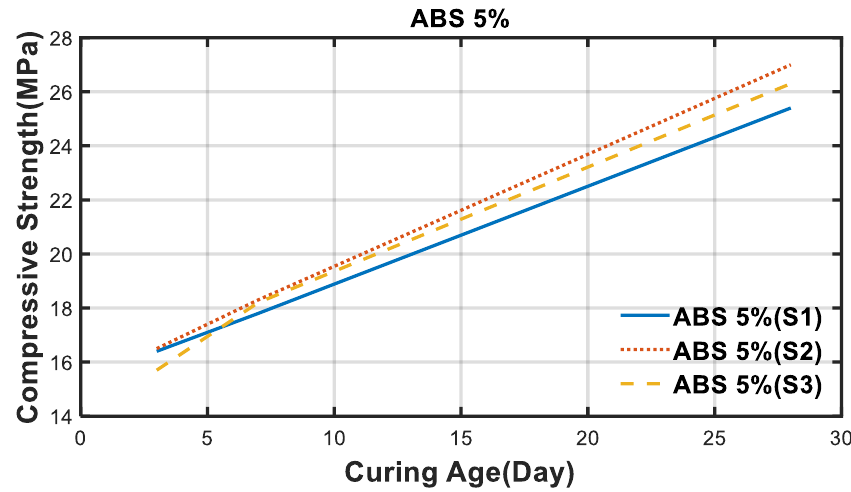
Figure 8. Graph of strength measurement results between ABS (5%) specimens.